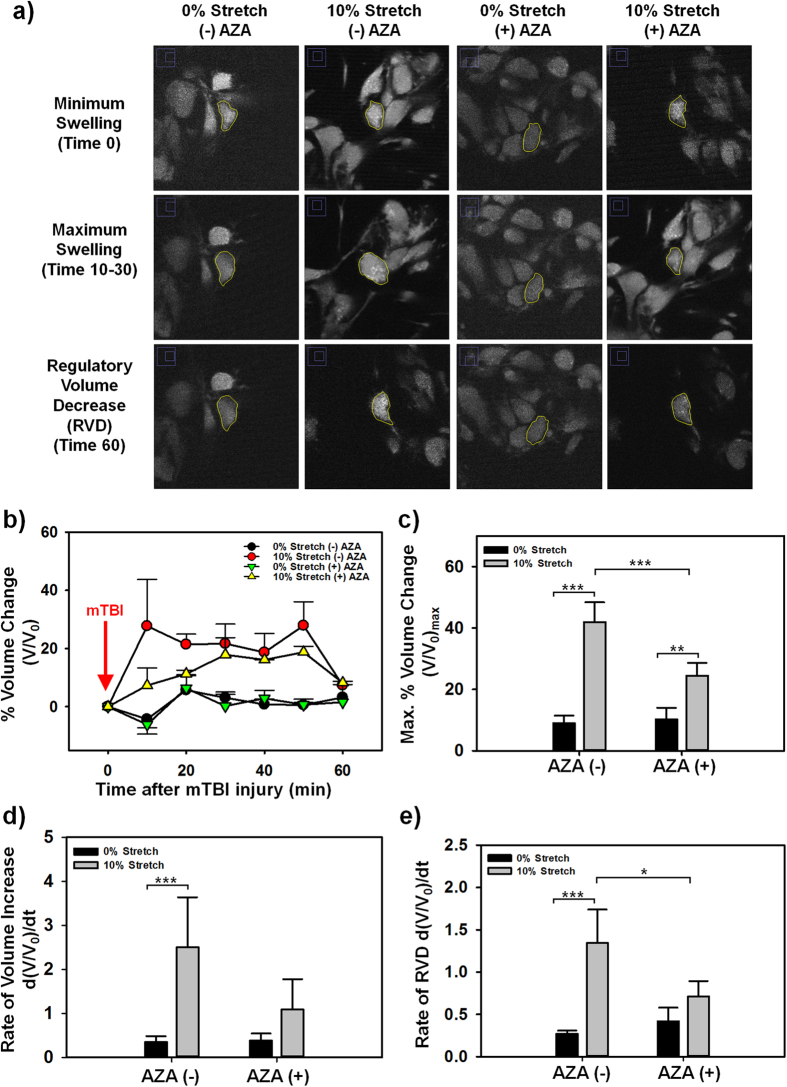
Analysis of astrocyte volume change.(a) Representative z-slices showing volume traces of selected cells (outlined with yellow lines). (b) Time course of change in astrocyte volume immediately post-mTBI. (c) Maximum increase in volume compared to volume at t = 0 (**p = 0.009, ***p < 0.001). (d) Rate of cell volume increase following mTBI injury or AZA treatment (***p < 0.001). (e) Rate of regulatory volume decrease (RVD) (*p = 0.024, ***p < 0.001).